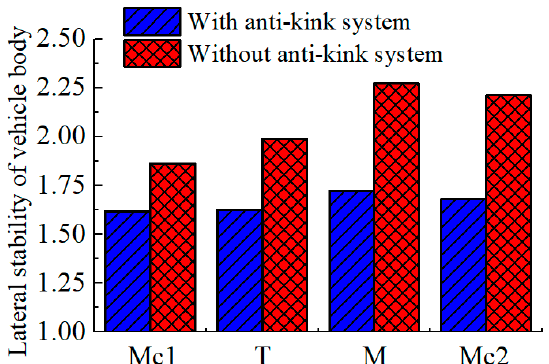
Figure 13. Lateral stability of vehicle body.